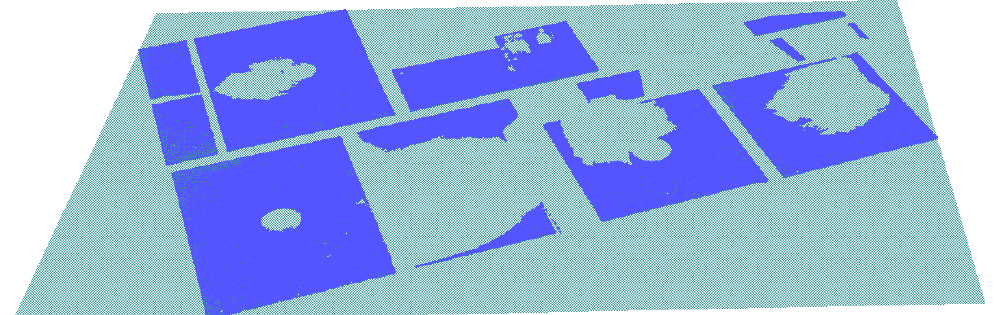
Figure 9. Disconnected coplanar regions as the result of occlusion present in the scene.